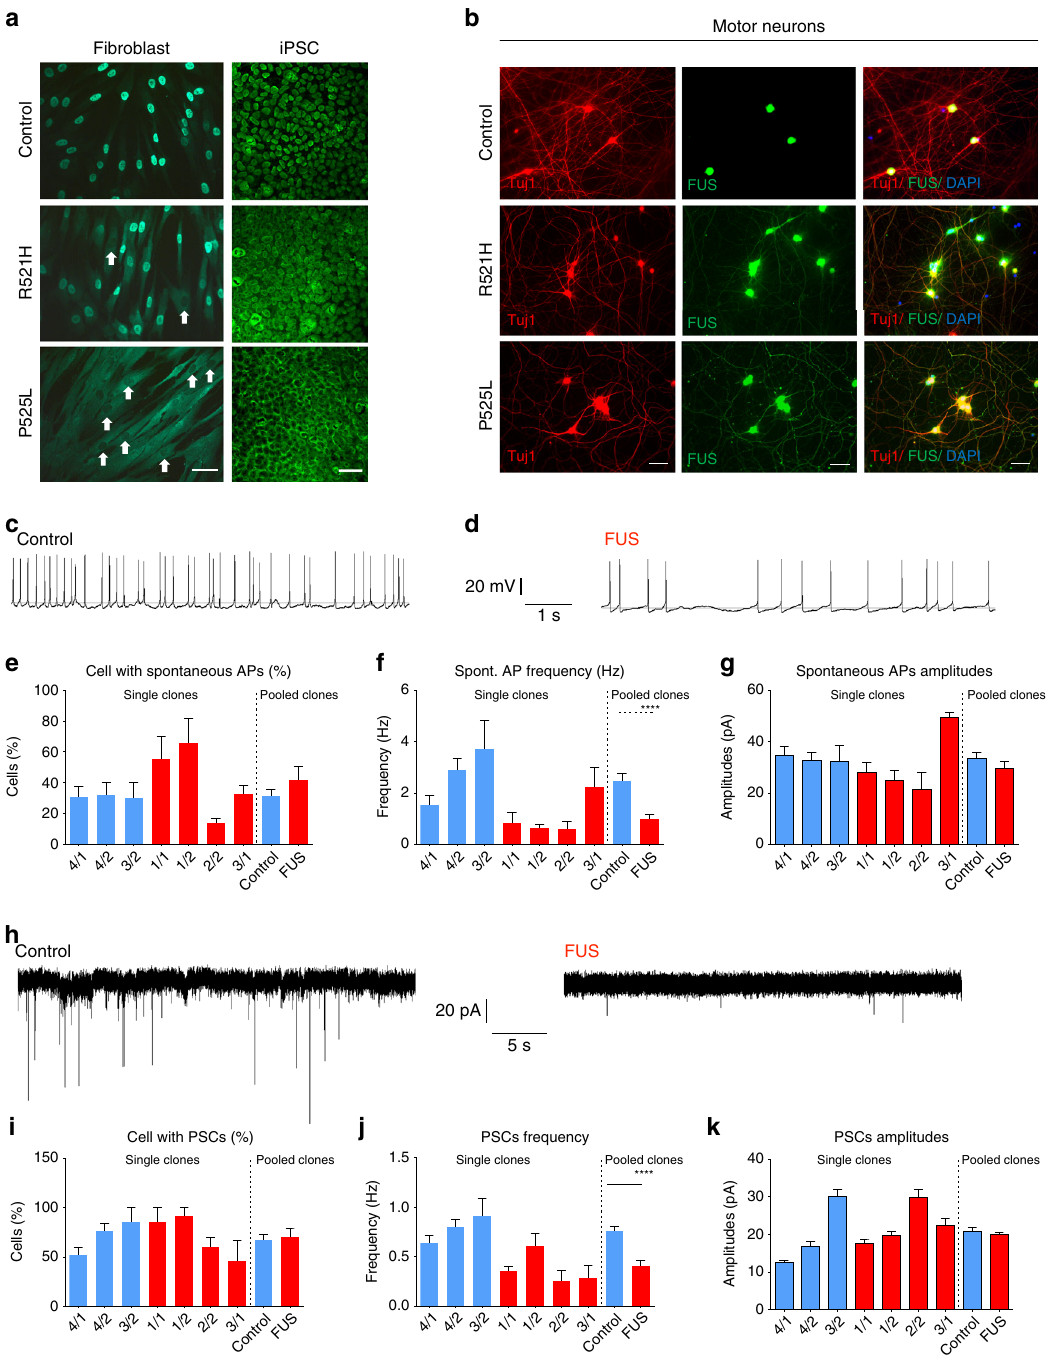
Fig. 2 ALS patient-derived MNs exhibit cytoplasmic FUS localization and hypoexcitability. a Immunostaining of FUS in fi broblasts and iPSCs from ALS patients and healthy controls. Nuclear clearance of FUS was observed in patient fi broblasts. White arrows highlight the nuclear clearance in patient fi broblasts carrying the R521H or P525L mutation. Scale bar = 70 µ m. b Immunostaining of FUS and Tuj1 with DAPI in motor neurons derived from iPSCs of ALS patients and healthy controls at the fourth week of differentiation. Scale bar = 70 µ m. c , d Representative traces of spontaneously occurring action potentials (APs) in healthy control and FUS iPSC-derived MNs during the seventh week of differentiation. e – g Characterization of MNs differentiated from iPSCs with spontaneous APs. The relative number of cells ( e n = 110 and n = 67 for control and patients, respectively), the frequency of spontaneous APs ( f , n = 48 and n = 34 for control and patients, respectively, Mann – Whitney test, **** P value is 0.0001) and the amplitude ( g n = 47 and n = 54 for control and patients, respectively) were measured. Data values represent mean ± SEM. h Representative traces of spontaneous postsynaptic currents (PSCs) in healthy control and FUS iPSC-derived MNs with typical MN appearance during the seventh week of differentiation. i – k Quanti fi cation of the relative number of cells with PSCs ( i n = 110 and n = 67 for control and patients, respectively), the PSC frequency ( j n = 91 and n = 57 for control and patients, respectively, Mann – Whitney test, **** P value is 0.0001) and the PSC ( k n = 91 and n = 57 for control and patients, respectively) amplitude in iPSCs-derived motor neurons from ALS patients and healthy